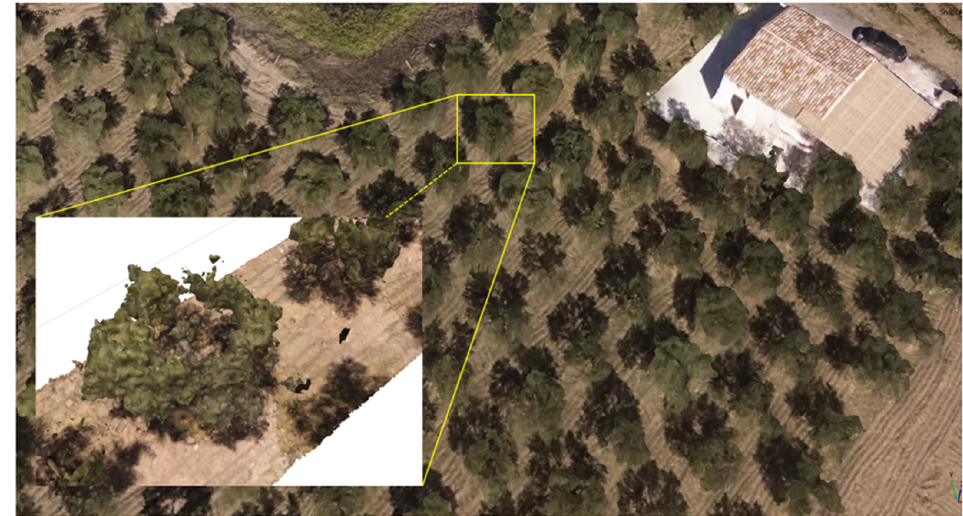
Figure 13. 3D reconstruction of the whole study area and zoom of one tree.